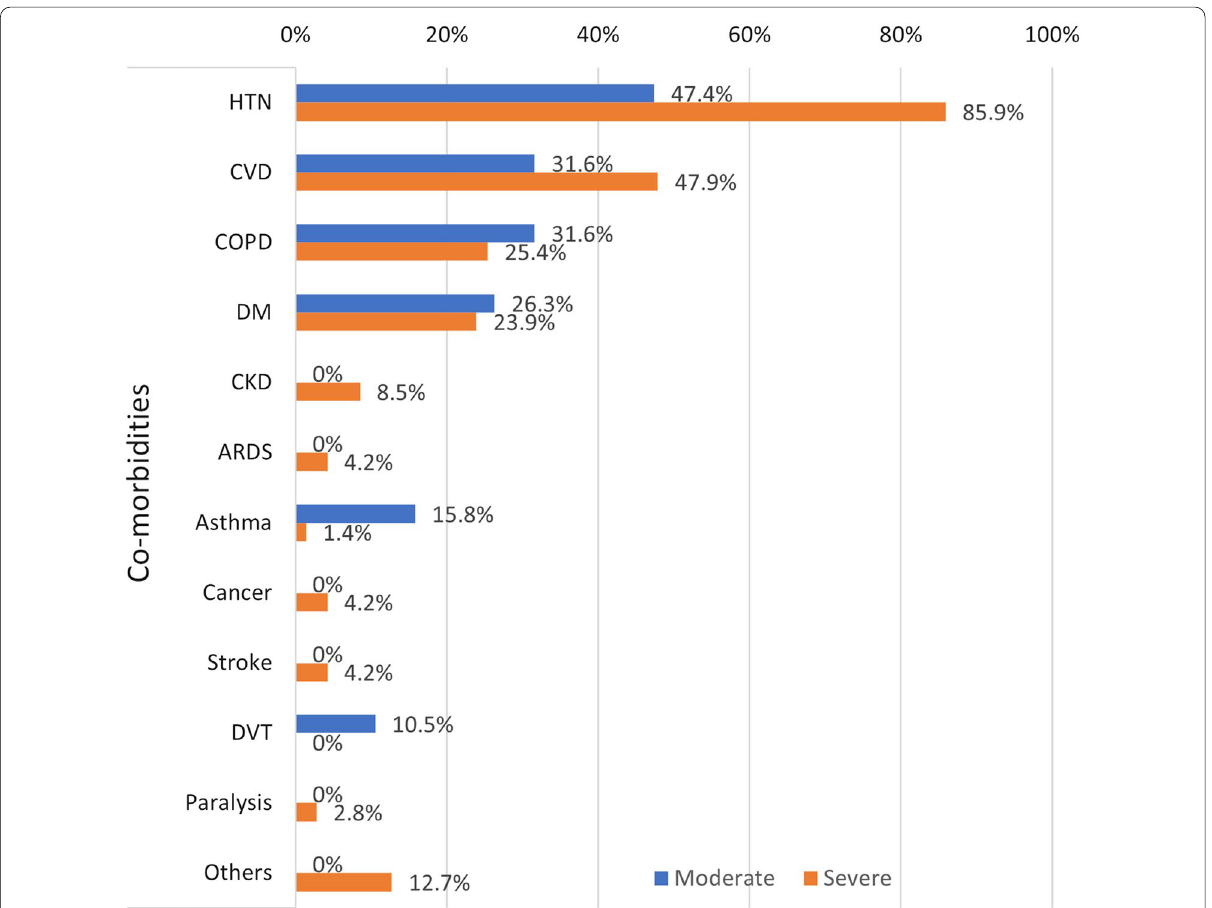
Fig. 1 Different comorbidities among the studied patients’